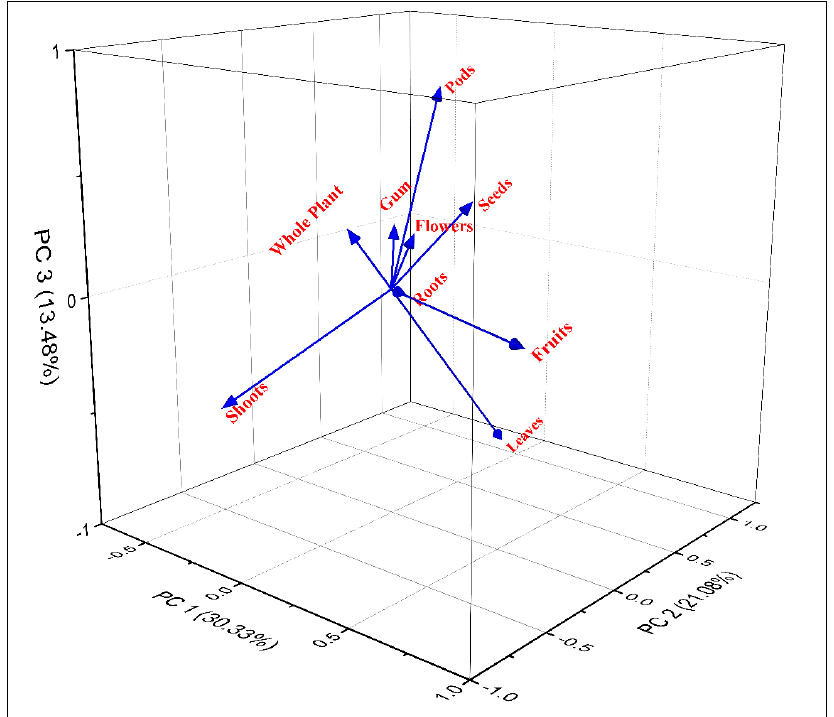
Figure 5. Principal Component Analysis (PCA) biplot of different plant parts used as food by local inhabitants of semi-arid region near Indo–Pak border Pakistan. inhabitants of semi-arid region near Indo–Pak border